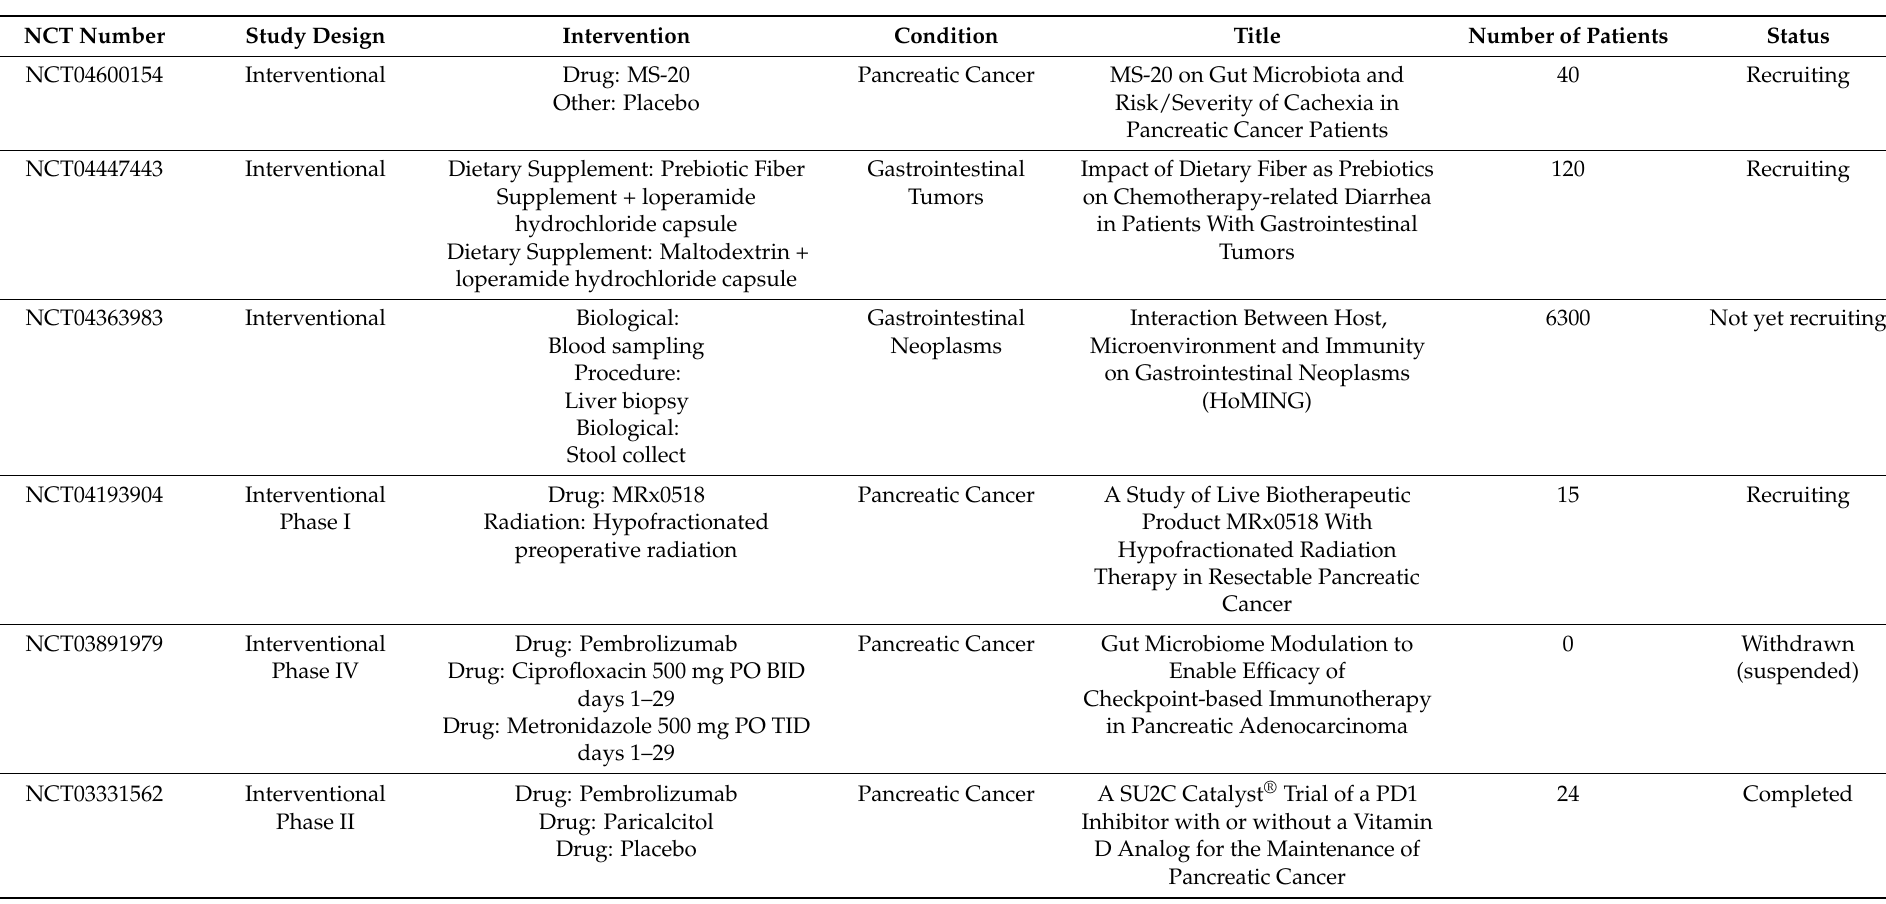
Table 5. Ongoing and completed interventional clinical trials testing the use of microbiota in combination with anticancer drugs in order to optimize drug efficacy or reduce side effects (source: https://clinicaltrials.gov, accessed on 24 February